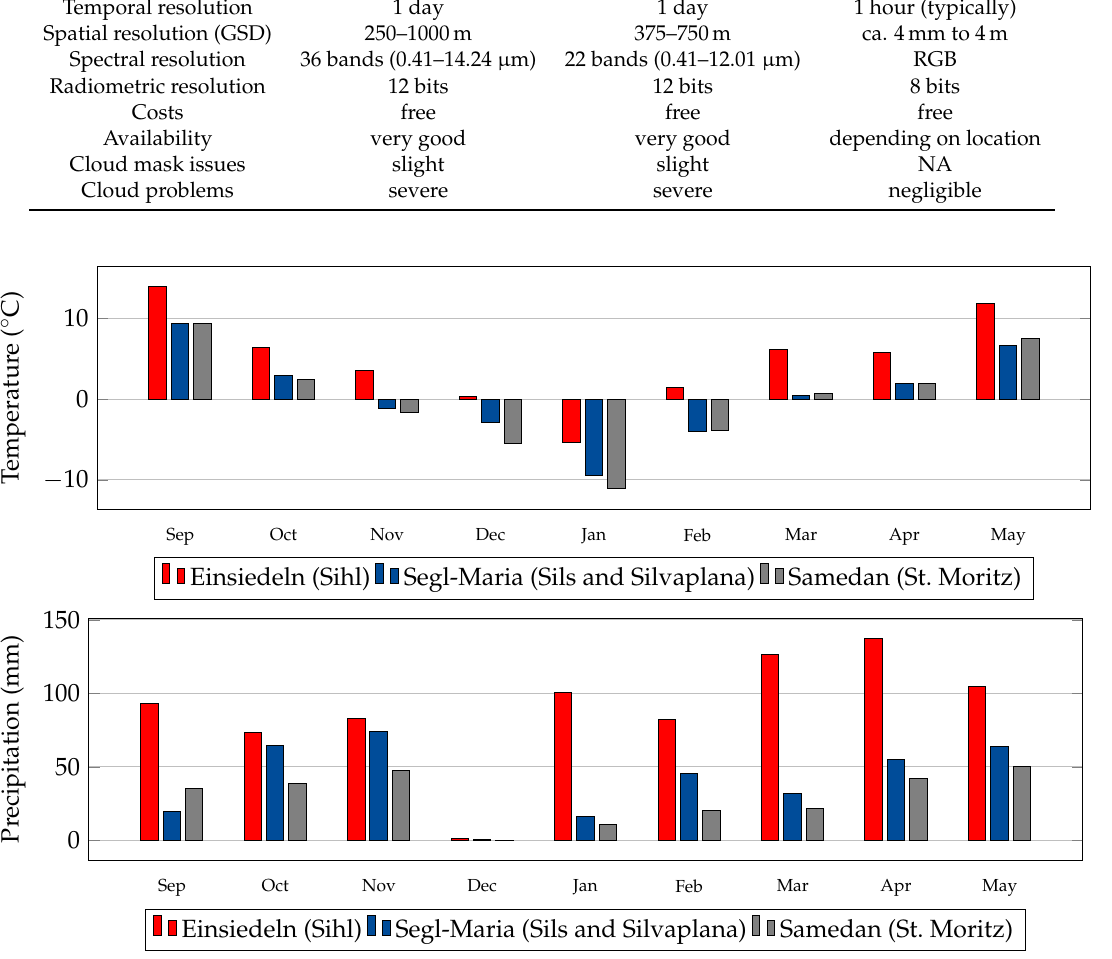
Figure 2. Bar graphs of mean monthly air temperature 2m above ground ( top ) and total monthly precipitation ( bottom ) in winter 2016–2017, recorded at the meteorological stations closest to the respective lakes. Data courtesy of